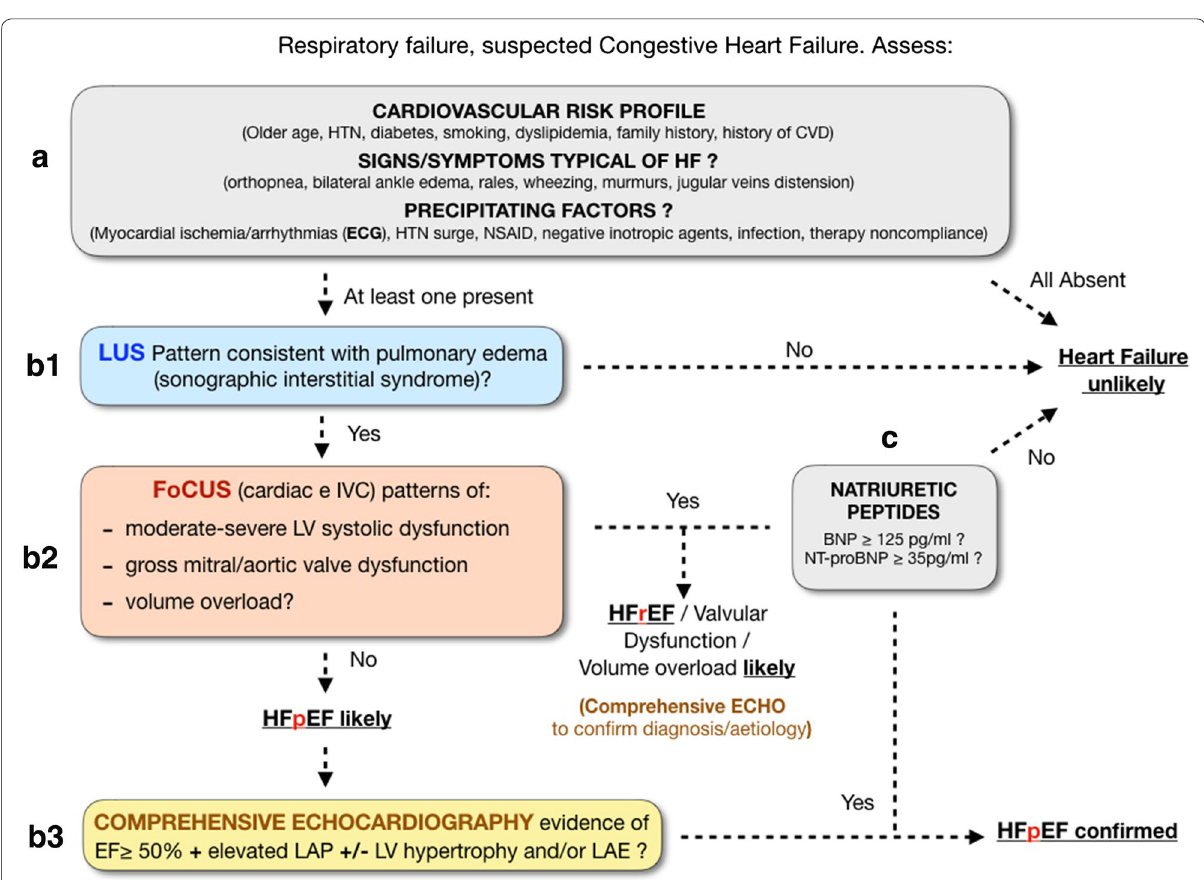
Fig. 1 Clinical-ultrasound integrated diagnostic approach to the patient with suspected congestive heart failure, focused on the diagnosis of heart failure (HF) with preserved ejection fraction (HFpEF). When facing respiratory distress, and congestive heart failure is suspected, history and a brief clinical exam should screen for cardiovascular risk factors, typical signs/symptoms of heart failure and for potential precipitating factors (step A). Multi-organ bedside ultrasound follows (step B), starting from lung ultrasound (B1): a pattern of bilateral, symmetrical, homogeneously diffuse scans with multiple B-lines (more than 2 positive chest areas per side sonographic interstitial syndrome) [32] is diagnostic for pulmonary edema. A = potential cardiac etiology of this pulmonary congestion is then screened for with Focused Cardiac Ultrasound (B2): the finding of moderate-severe left ventricular systolic dysfunction raises high suspicion for congestive high failure with reduced ejection fraction (HFrEF). This can then be confirmed with the echocardiographic demonstration of high left atrial filling pressures. Alternatively, FoCUS findings of gross valvular dysfunction or pure volume overload (if consistent with history) will suggest a different cardiogenic or a hydrostatic cause of the pulmonary edema. Immediate or delayed comprehensive echocardiography will again confirm the diagnosis and clarify the mechanism and degree of valvular dysfunction. When all the FoCUS findings consistent with potential causes of pulmonary edema are ruled out, comprehensive echocardiography (B3) is even more required to confirm/rule out a likely diagnosis of heart failure with preserved ejection fraction (HFpEF, defined as ejection fraction 50%, with ≥ TDI and Doppler indices diagnostic for elevated left atrial pressures, with/without left ventricular hypertrophy or left atrial enlargement [2]). The diagnosis of HFpEF finally requires a concomitant positive natriuretic peptides assay (step C). Natriuretic peptides must in any case be pathological for the diagnosis of any alternative cardiogenic cause of pulmonary edema (either HFrEF or HF caused by valvular dysfunction). HTN hypertension, CVD cardiovascular disease, HF heart failure, ECG electrocardiography, NSAIDS non steroid anti-inflammatory drugs, LUS lung ultrasound, FoCUS focused cardiac ultrasound, IVC inferior vena cava, LV left ventricle, EF ejection fraction, LAP left atrial pressure, LAE left atrial enlargement, HFpEF heart failure with preserved ejection fraction, HFrEF heart failure with reduced ejection fraction, BNP brain natriuretic